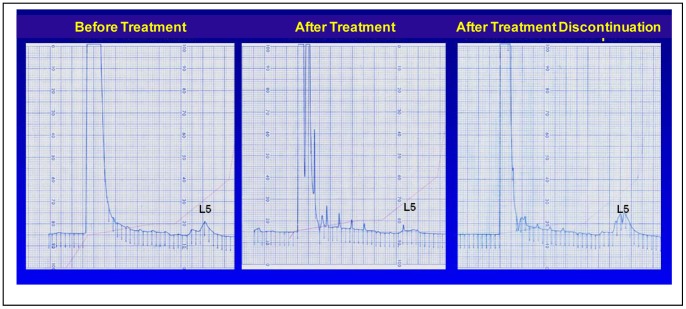
Anion-exchange chromatography of low-density lipoprotein (LDL) from a hypercholesterolemic patient.Chromatograms showing the L5 percentage before treatment (left), after 3 months of atorvastatin treatment (10 mg/day; center), and 3 months after the discontinuation of treatment (right) in hypercholesterolemic patient (baseline plasma LDL-cholesterol level, 226 mg/dL). Treatment with atorvastatin for 3 months reduced the level of L5, and discontinuation of treatment for 3 months resulted in the recurrence of elevated L5.